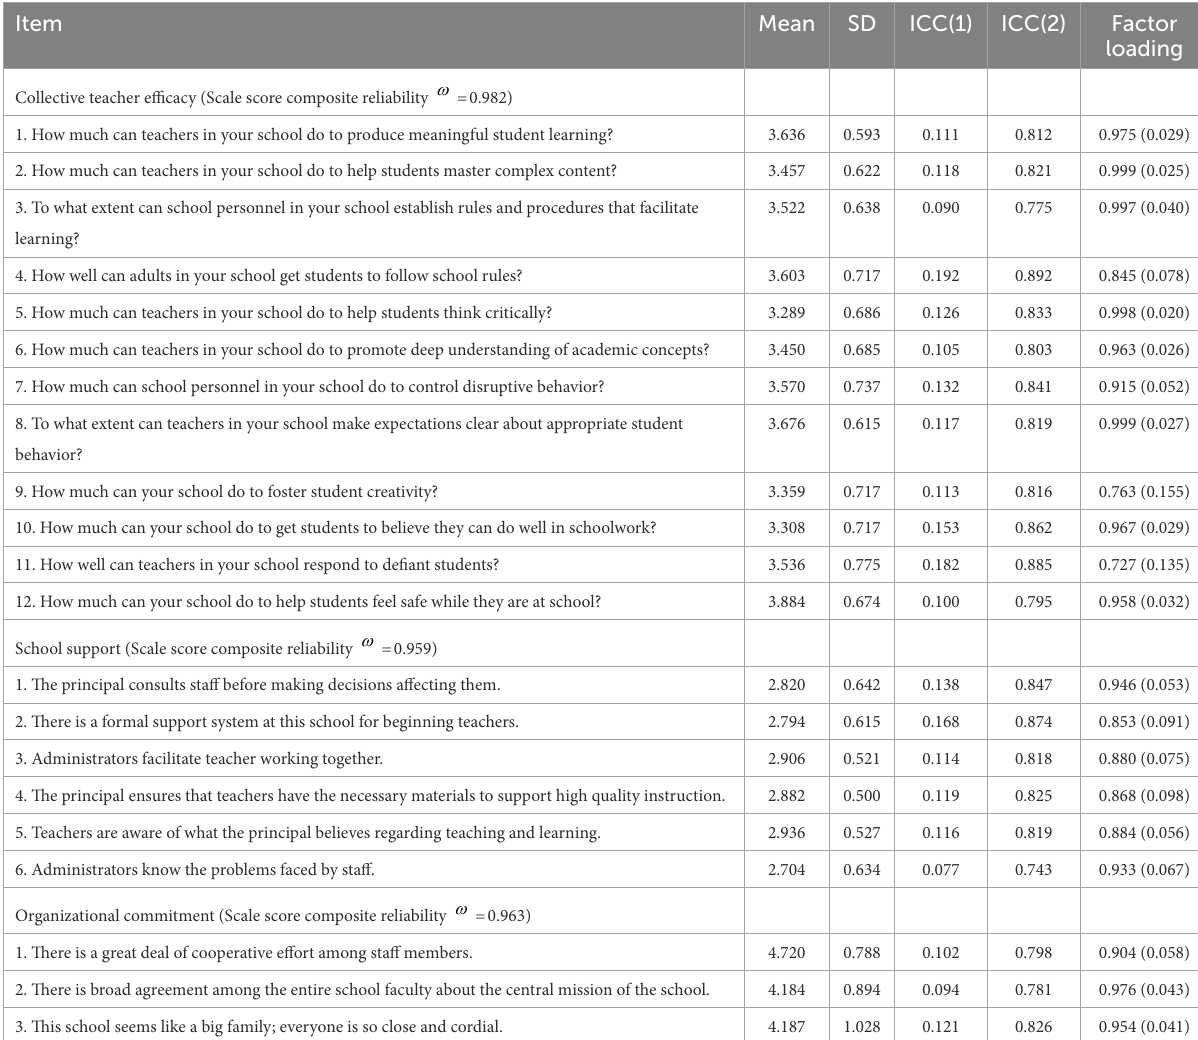
TABLE 1 Descriptive statistics, ICC(1), ICC(2), and standardized school-level factor loadings and the associated standard errors for items measuring collective teacher efficacy, school support, and organizational commitment.